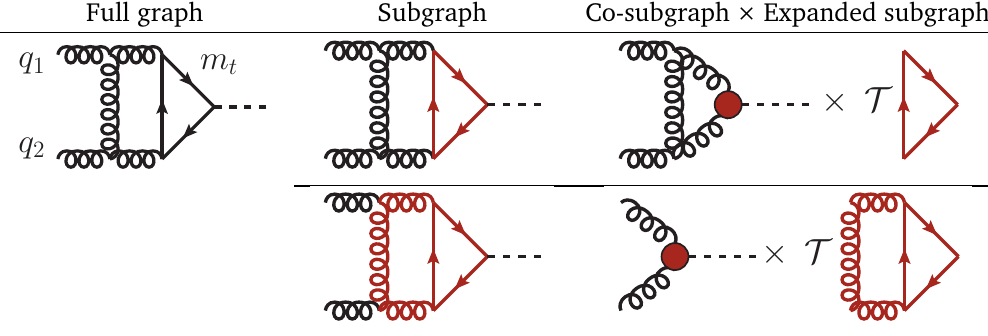
Figure 1: Starting from the full Feynman graph of the first column, we identify the subgraphs which contain m subgraphs are expanded in the large- m only co-subgraphs which are independent of m